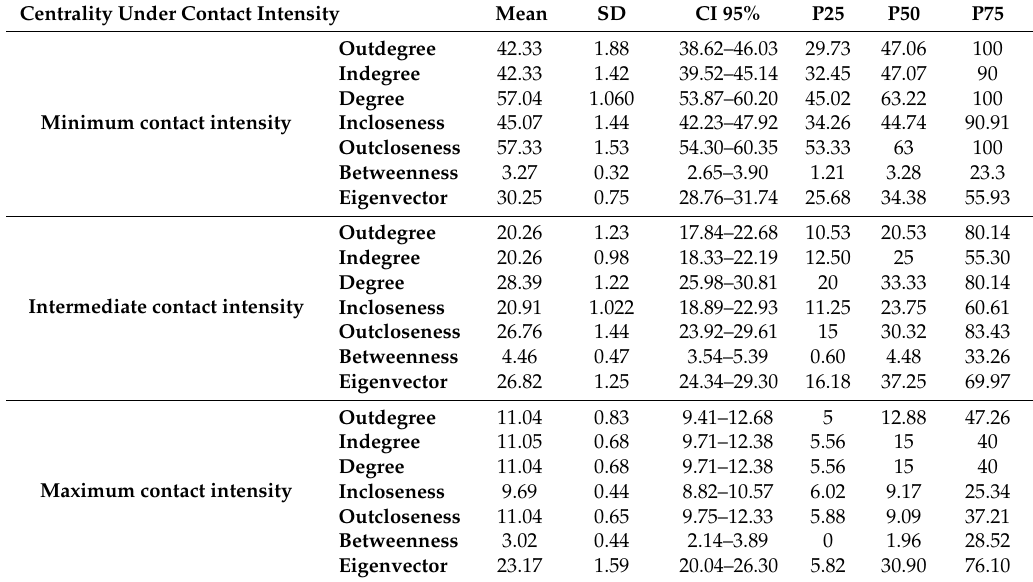
Table 2. Descriptive statistics for relational variables according to contact intensity between